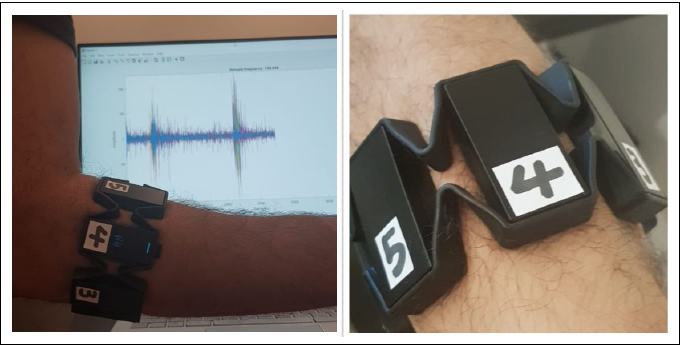
Figure 3. Acquisition of sEMG data of a user to create the database